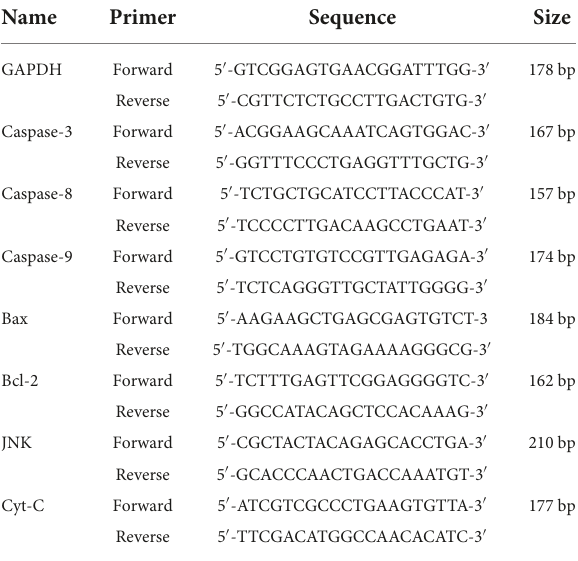
TABLE 2 PCR amplification primer design for apoptosis-related